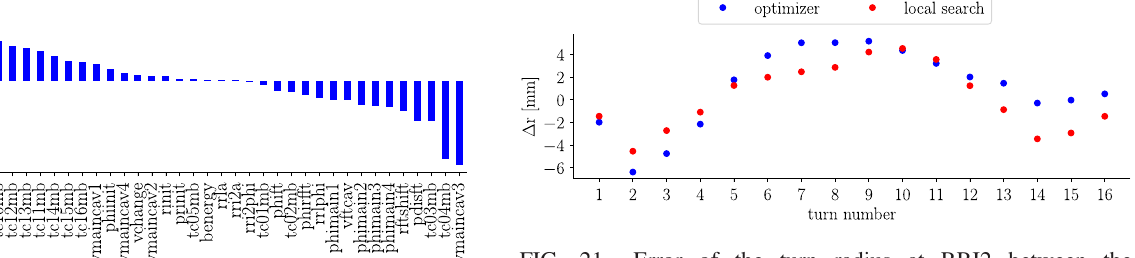
FIG. 21. Error of the turn radius at RRI2 between the measurement and simulation of the best individual obtained by multiobjective optimization and local search.